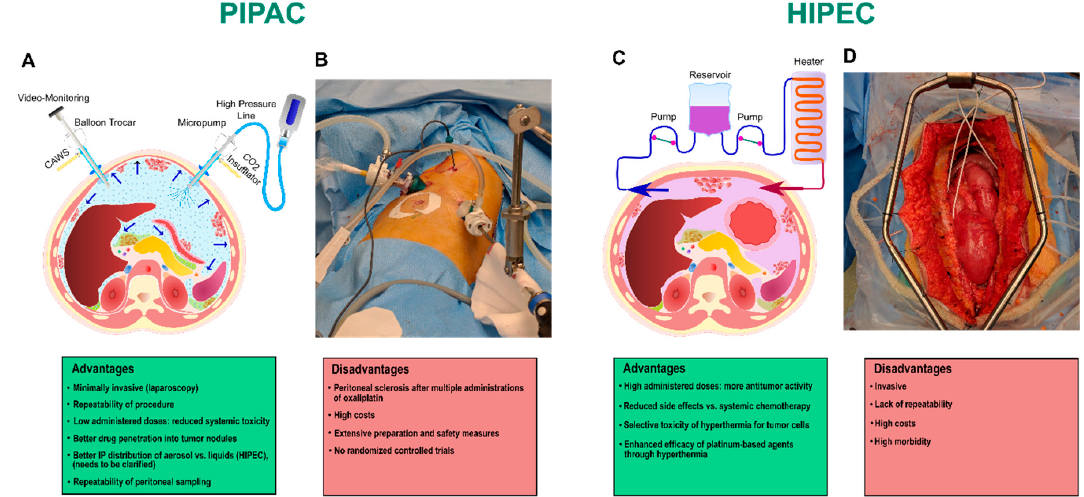
Figure 1. Examples of intraperitoneal chemotherapy methods along with representative advantages and disadvantages of each approach. ( A ) Schematic illustration and ( B ) surgical procedure of Pressurized Intraperitoneal Aerosol Chemotherapy (PIPAC). ( C ) Schematic illustration and ( D ) surgical procedure of Hyperthermic Intraperitoneal Chemotherapy (HIPEC).